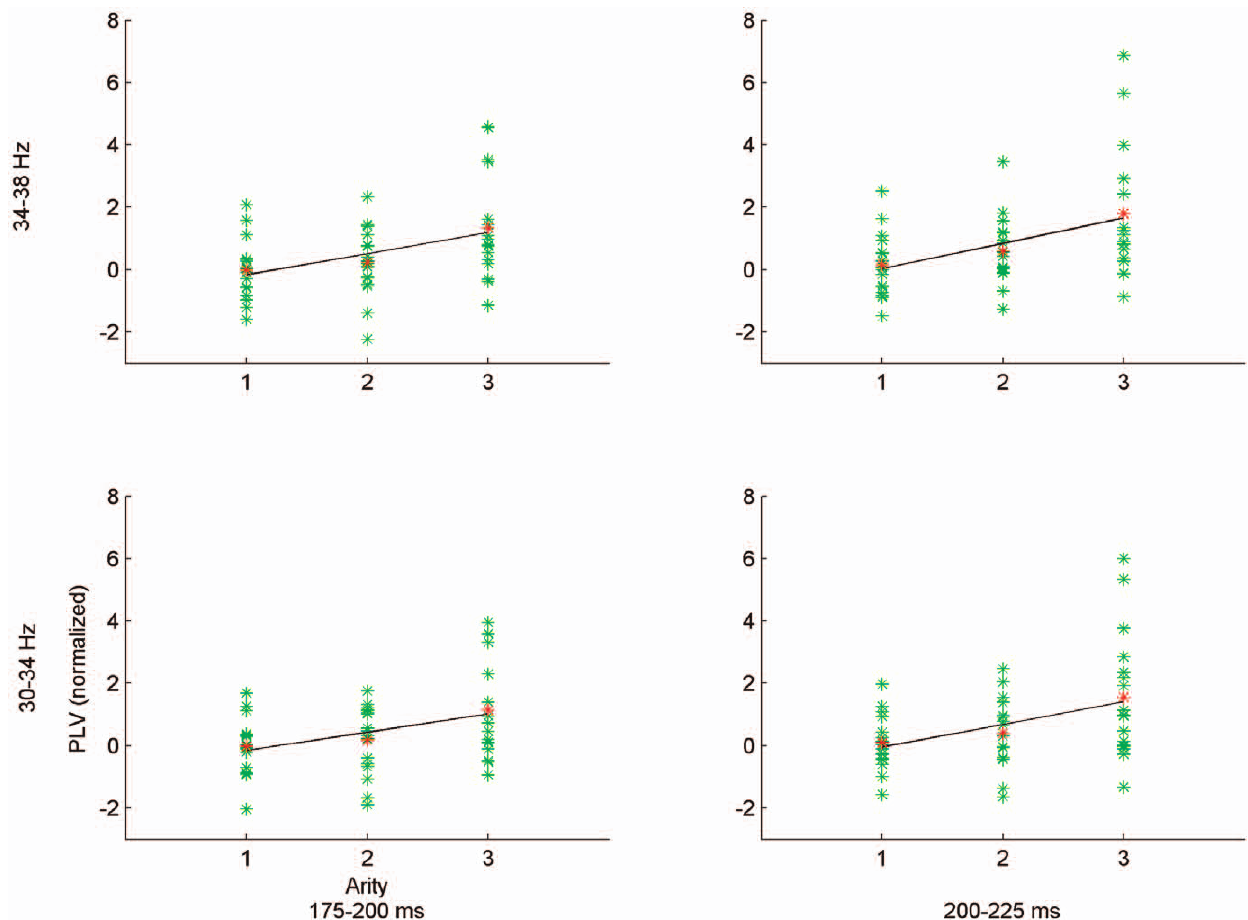
Figure 5. PLV-arity plots for full data set. Plot of PLV at each arity for each participant (green) and their mean (red) for significant frequency-time bands from the mean of F3-P3, Fz-Pz, and F4-P4 electrode pairs. Line indicates the regression slope.